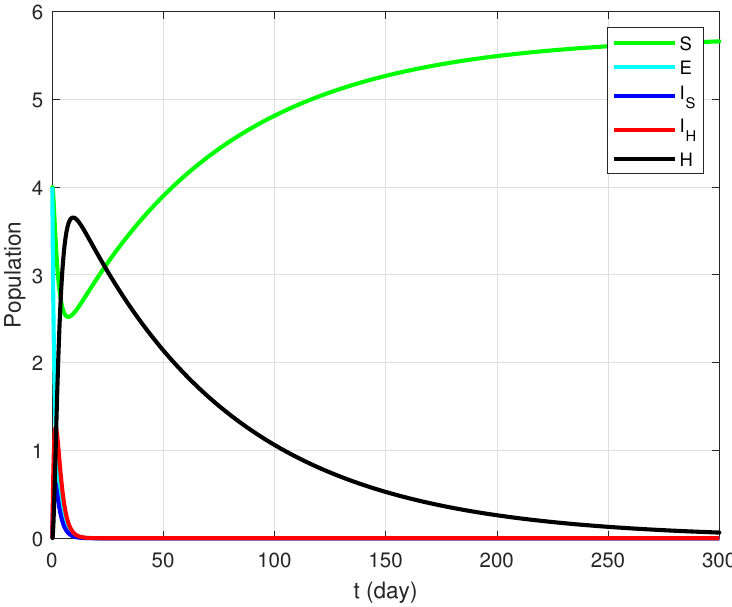
Figure 3. The dynamics of all classes when we set the parameters α = 3 and η = 1. The non-endemic point P 0 is asymptotically